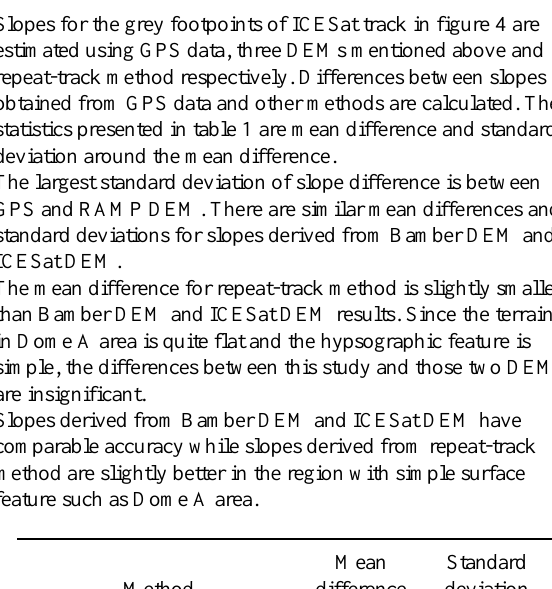
Figure 3. Antarctic ice sheet surface slope from ICESat repeat orbit data.